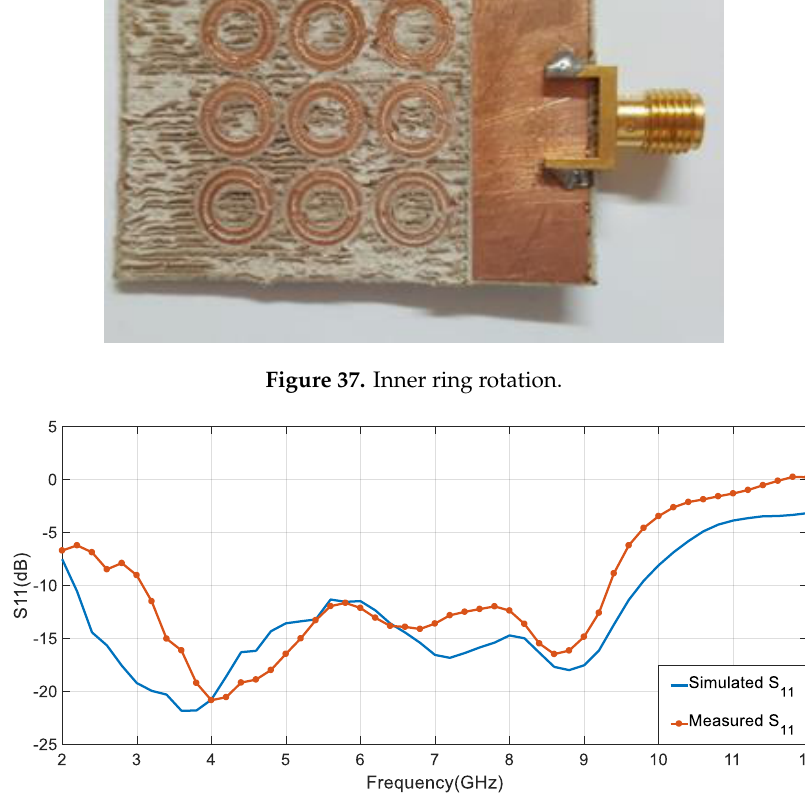
Figure 38. Simulated and measured S 11.